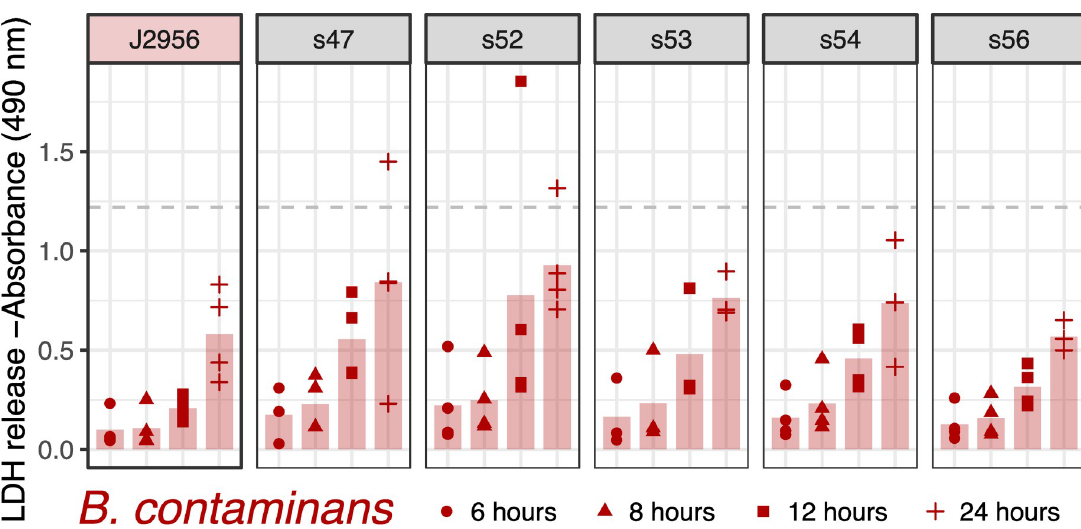
Fig 5. B . contaminans lactase dehydrogenase (LDH) release from macrophage. Same as Fig 4, but here for B . contaminans with terrestrial reference strain J2956. As compared to the reference strain via two-sided t-tests, none were found to have an adjusted p- value < 0.68 (adjusted by Bonferonni correction).